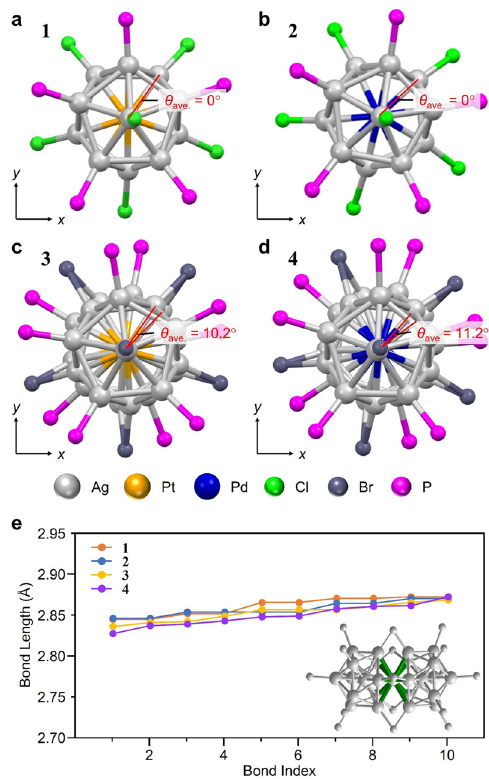
Fig. 2 Structural analysis of the twist between the two Ag 12 M structures (M = Pt or Pd). a – d View from the long-axis direction for 1 , 2 , 3 and 4 , respectively, showing the twist between the two Ag 12 M structures (M = Pt or Pd) in the cores of 3 and 4 (grey = Ag; orange = Pt; blue = Pd; green = Cl; dark grey = Br; magenta = P). The geometric structure of 1 and 2 are reproduced from ref. 28,31 , respectively. In a − d , θ ave indicates the average dihedral angle between the two Ag 12 M structures. e Comparison of the Ag − Ag bond length between the joining Ag and the neighbouring Ag (green line), showing that the bond lengths are quite similar in 1 − 4